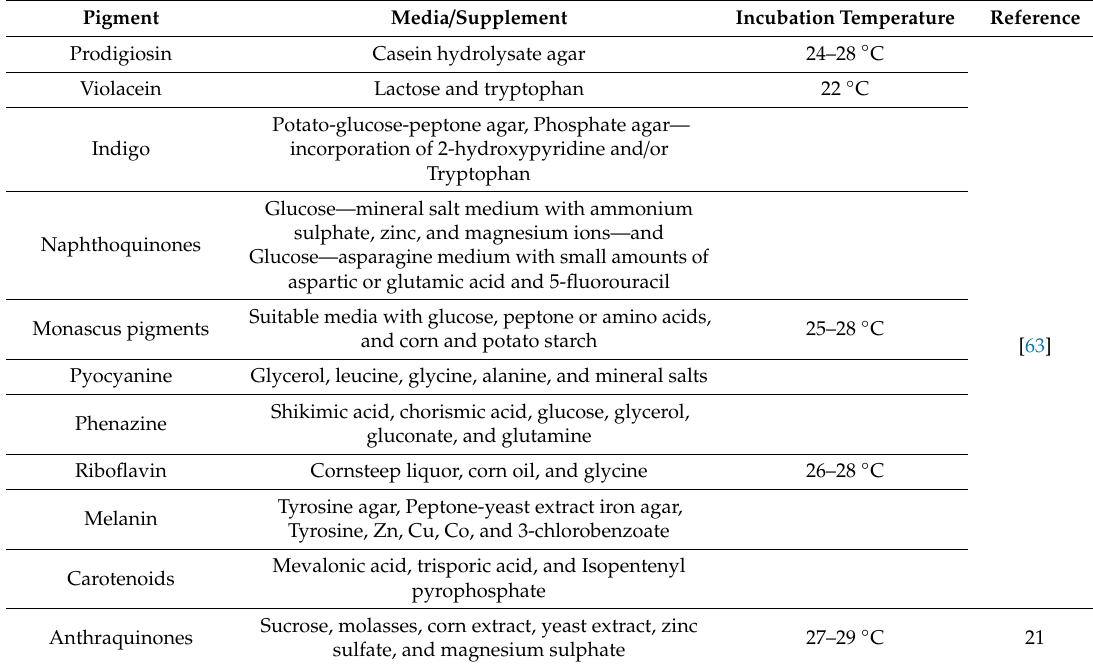
Table 1. Various media and supplements required for extraction of specific pigments from di ff erent